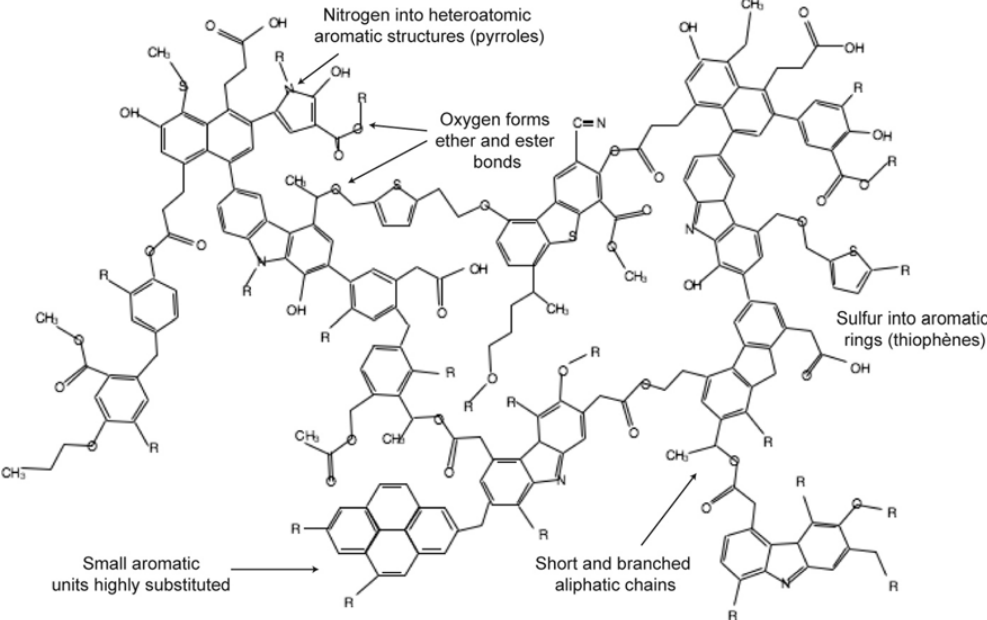
Figure 3. Summary of molecular information on the chemical structure of IOM of Murchison. R means an organic moiety. This picture was established thanked to data collected from 20 years and summarized in table 2. (This figure is modified from Derenne and Robert (2010), «Model of molecular structure of the insoluble organic matter isolated from Murchison meteorite », Meteoritics and Planetary Science, doi: